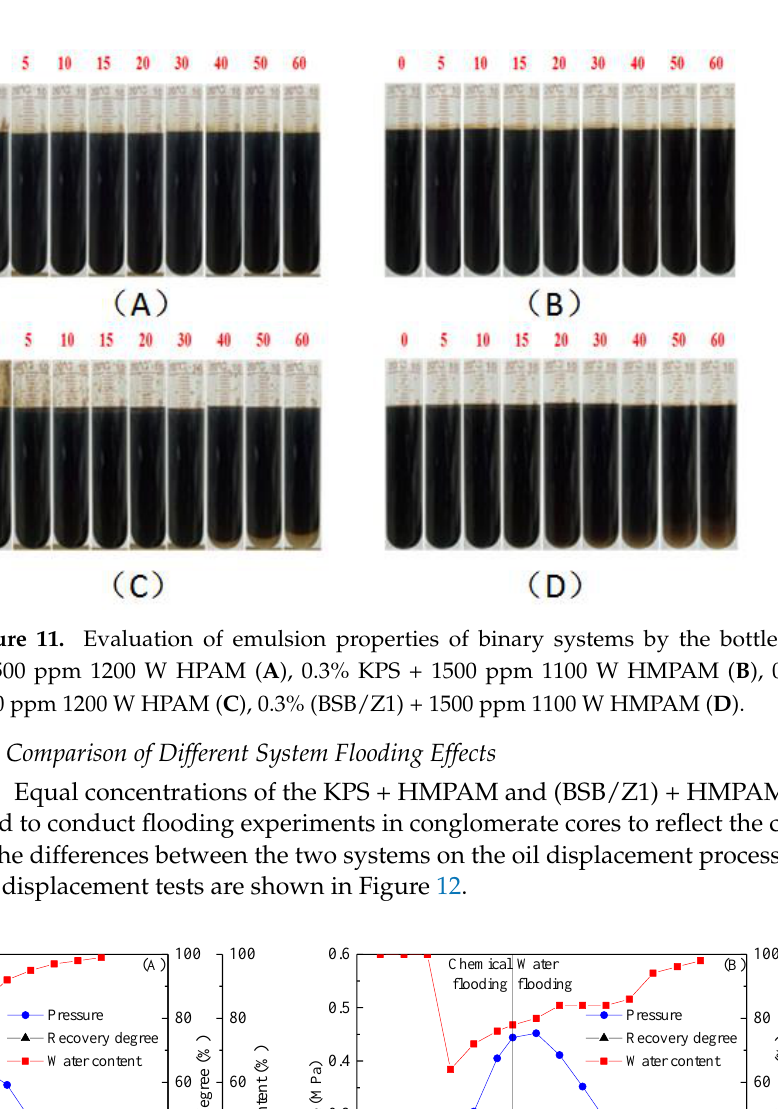
Figure 11. Evaluation of emulsion stability by the bottle test: 0.3% KPS ( A ), 0.3% (BSB/Z1 = 2/1) ( B ),